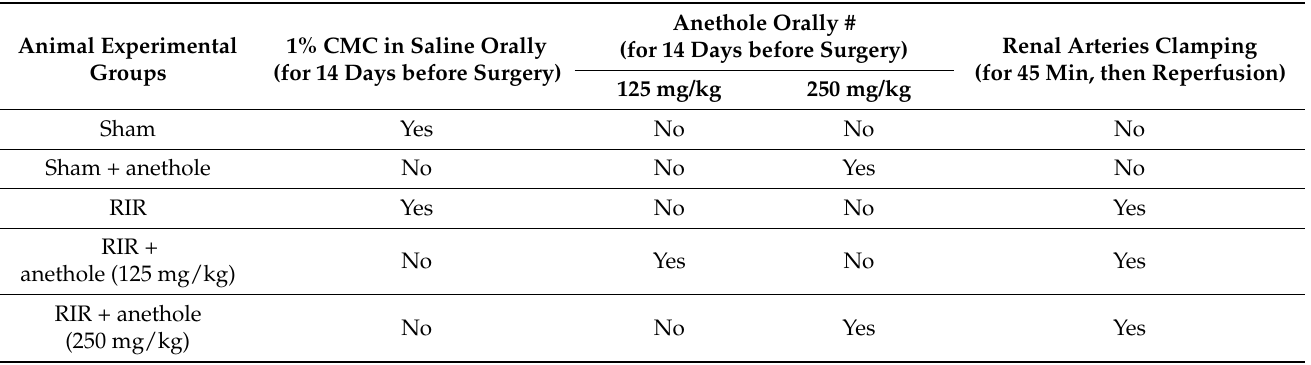
Table 1. Animal experimental design. The differences between the five groups of animals specified in the experimental design